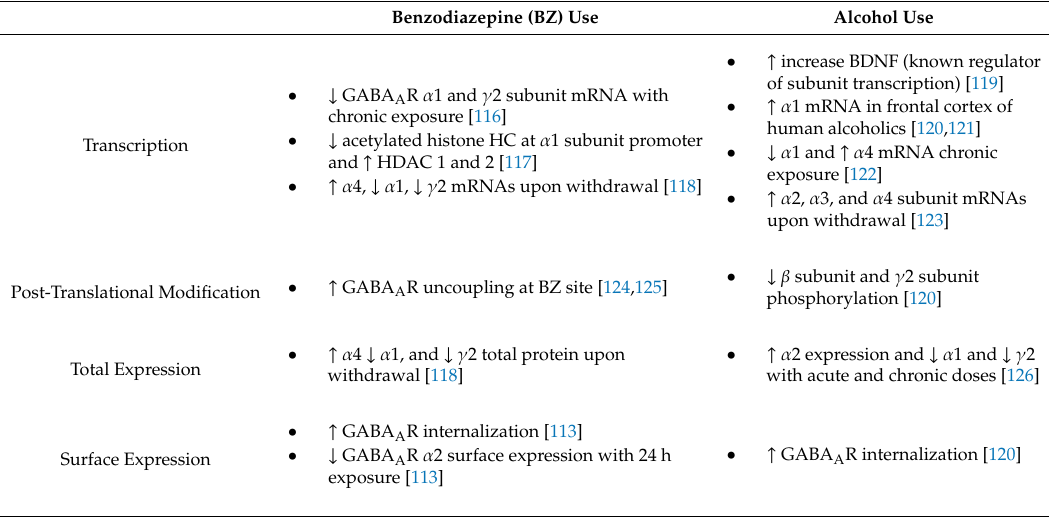
Table 1. Summary of the regulation of GABA A receptor subunits with benzodiazepine (BZ) and alcohol use, and